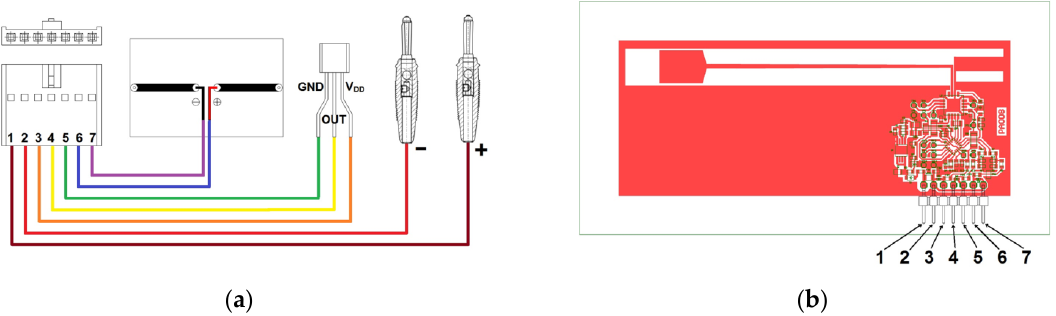
Figure 8. Single-board RFID sensor: ( a ) wire interface for implementation in active glazing unit; ( b ) input description: 1 —PV cells “+”, 2—PV cells “ − “, 3— V DD for external temperature sensor,